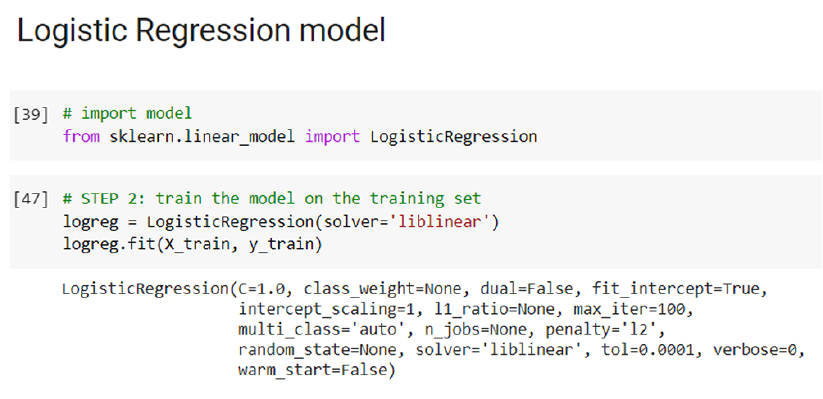
Fig. 3. Logistic Regression model